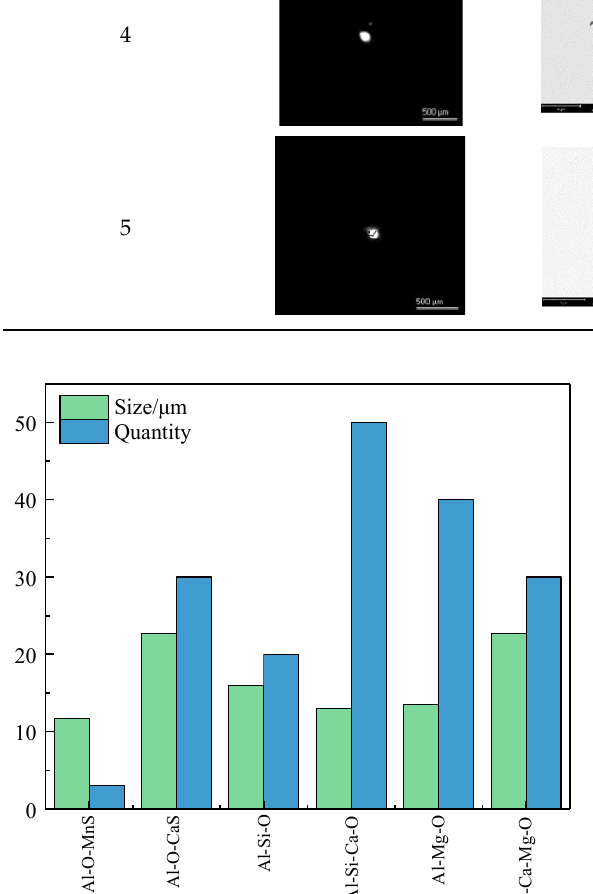
Figure 8. Electron microscope images and elements mapping after dissection of the maximum defect. The large inclusions on the scanning surface were statistically analyzed, and the number,